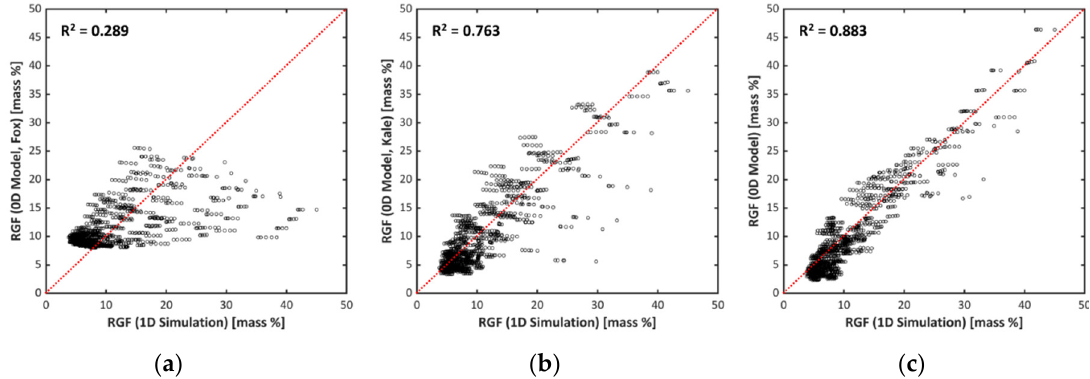
Figure 11. Matching results of conventional models: ( a ) Fox’s 0D RGF model; ( b ) Kale’s 0D RGF model; ( c ) Improved model